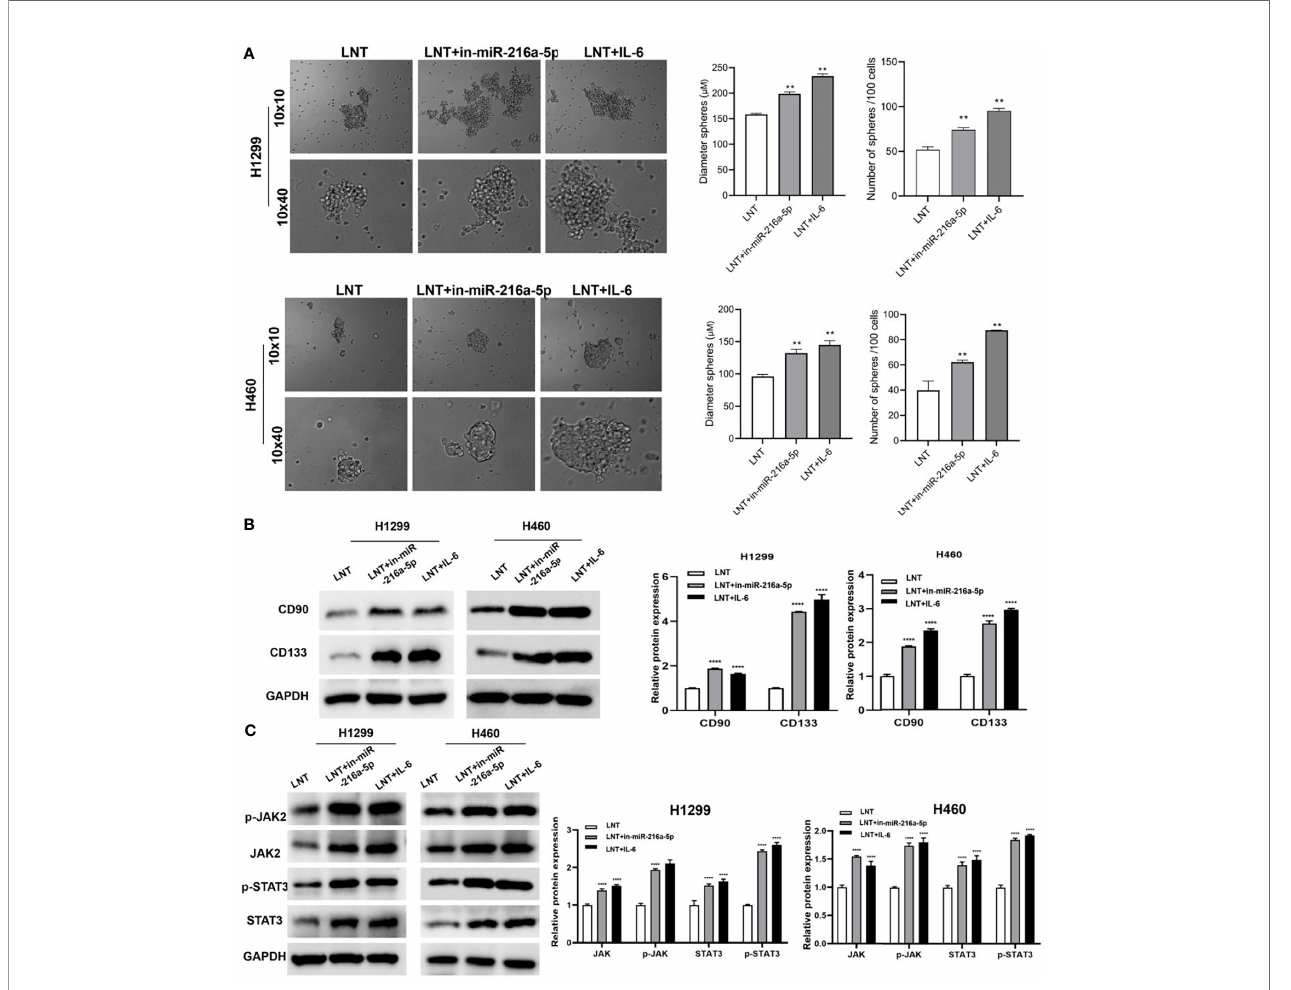
FIGURE 5 | The effect of interfering with miR-216a-5p or IL-6 on LNT promoting cancer cell stemness and the JAK2/STAT3 pathway. (A) Stem cell sphere-forming assay to detect the spheroidization ef fi ciency of H1299 and H460 cells in each group; (B) Western blot to detect H1299 and H460 cells stem cell marker proteins CD90 and CD133 expression; (C) Western blot to detect H1299 and H460 cells JAK2/STAT3 signaling pathway protein expression in each group. **P < 0.01 and ****P < 0.0001 vs . LNT